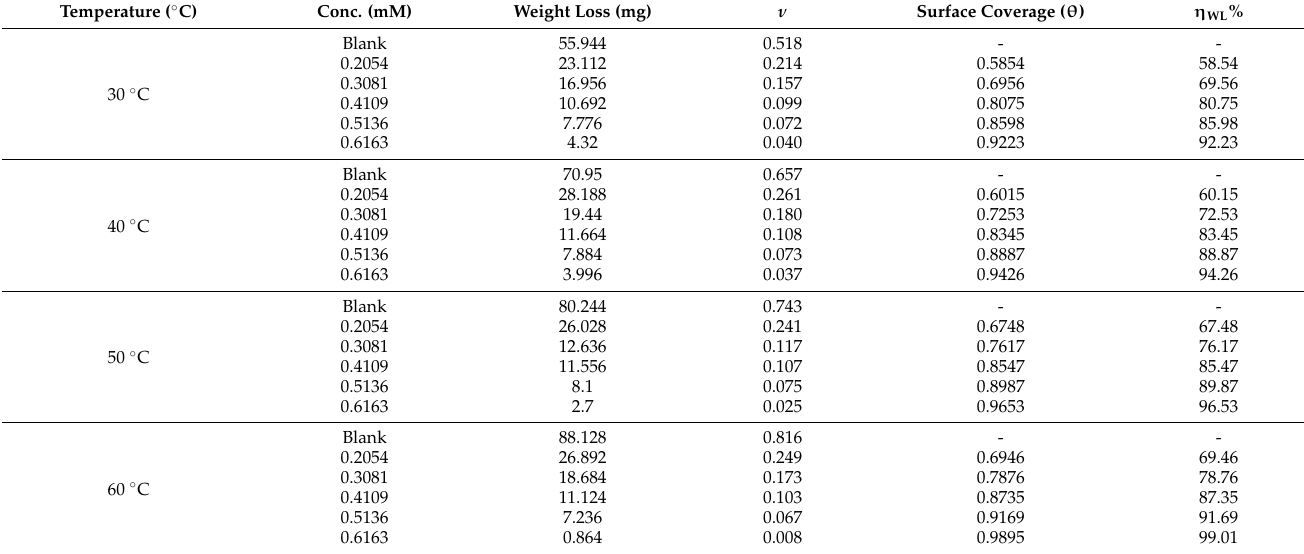
Table 1. WL parameters for mild steel corrosion in 1 M HCl at different doses of CMEA at 30– 60 ℃ .